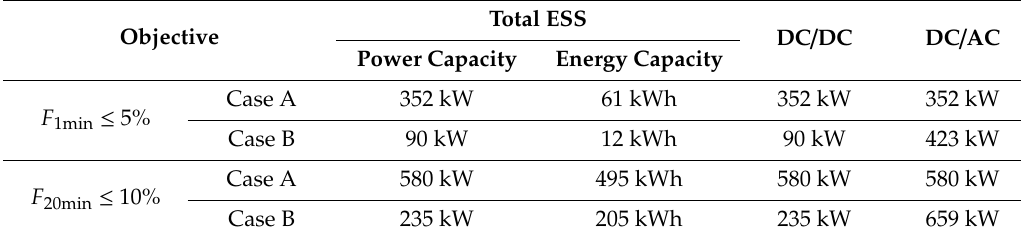
Table 6. Results of total ESS and PCS capacity configuration of di ff erent